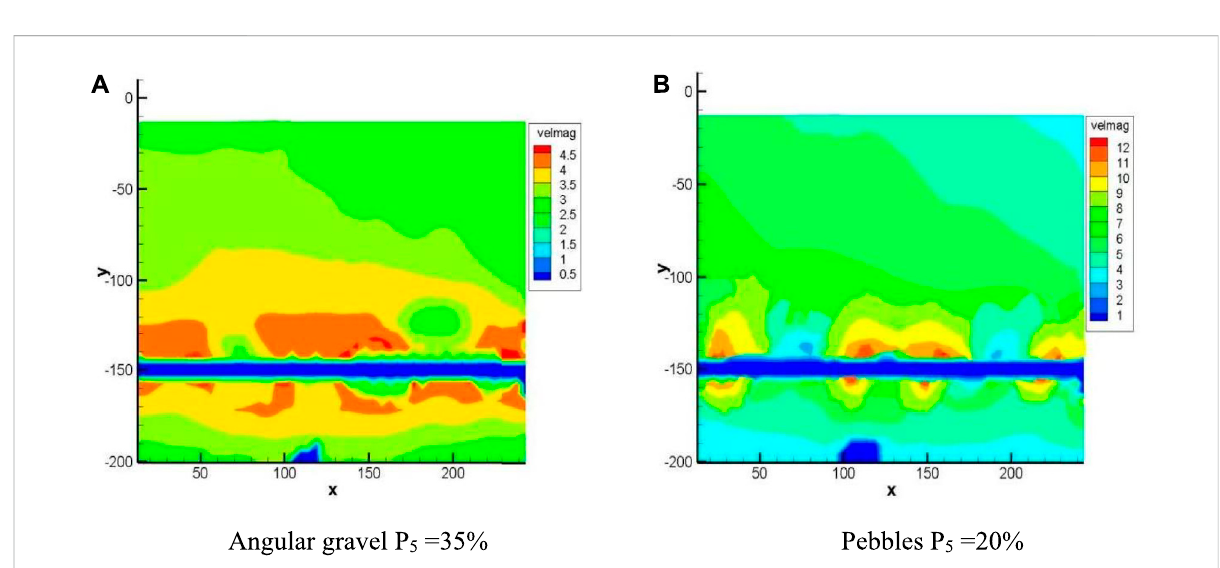
FIGURE 9 The displacement cloud map under different types of soil materials (at the pullout peak). (A) Angular gravel P5 =35% (B) Pebbles P5